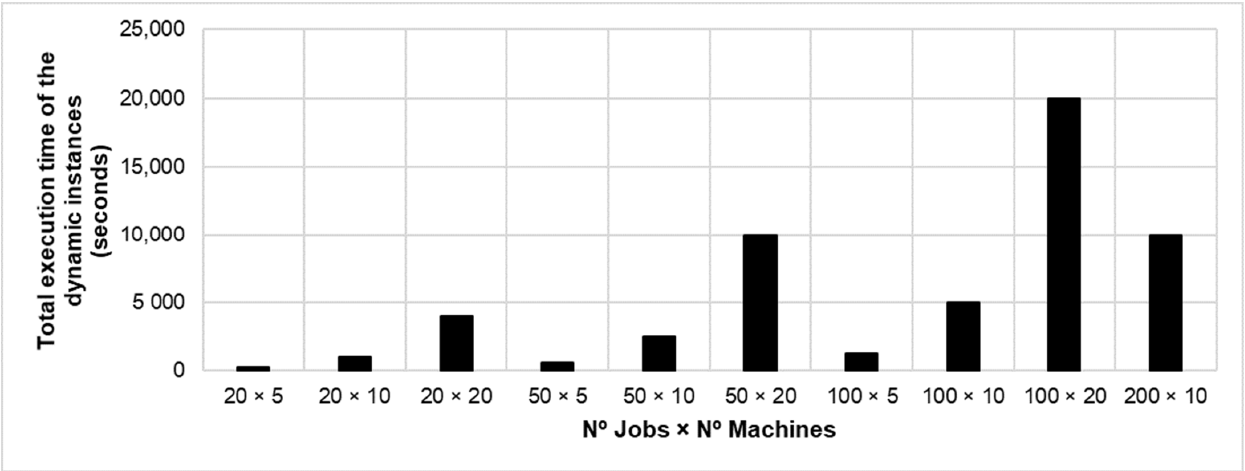
Figure 9. Dynamic Pareto evolution for RIPG in TA_100_20_6.